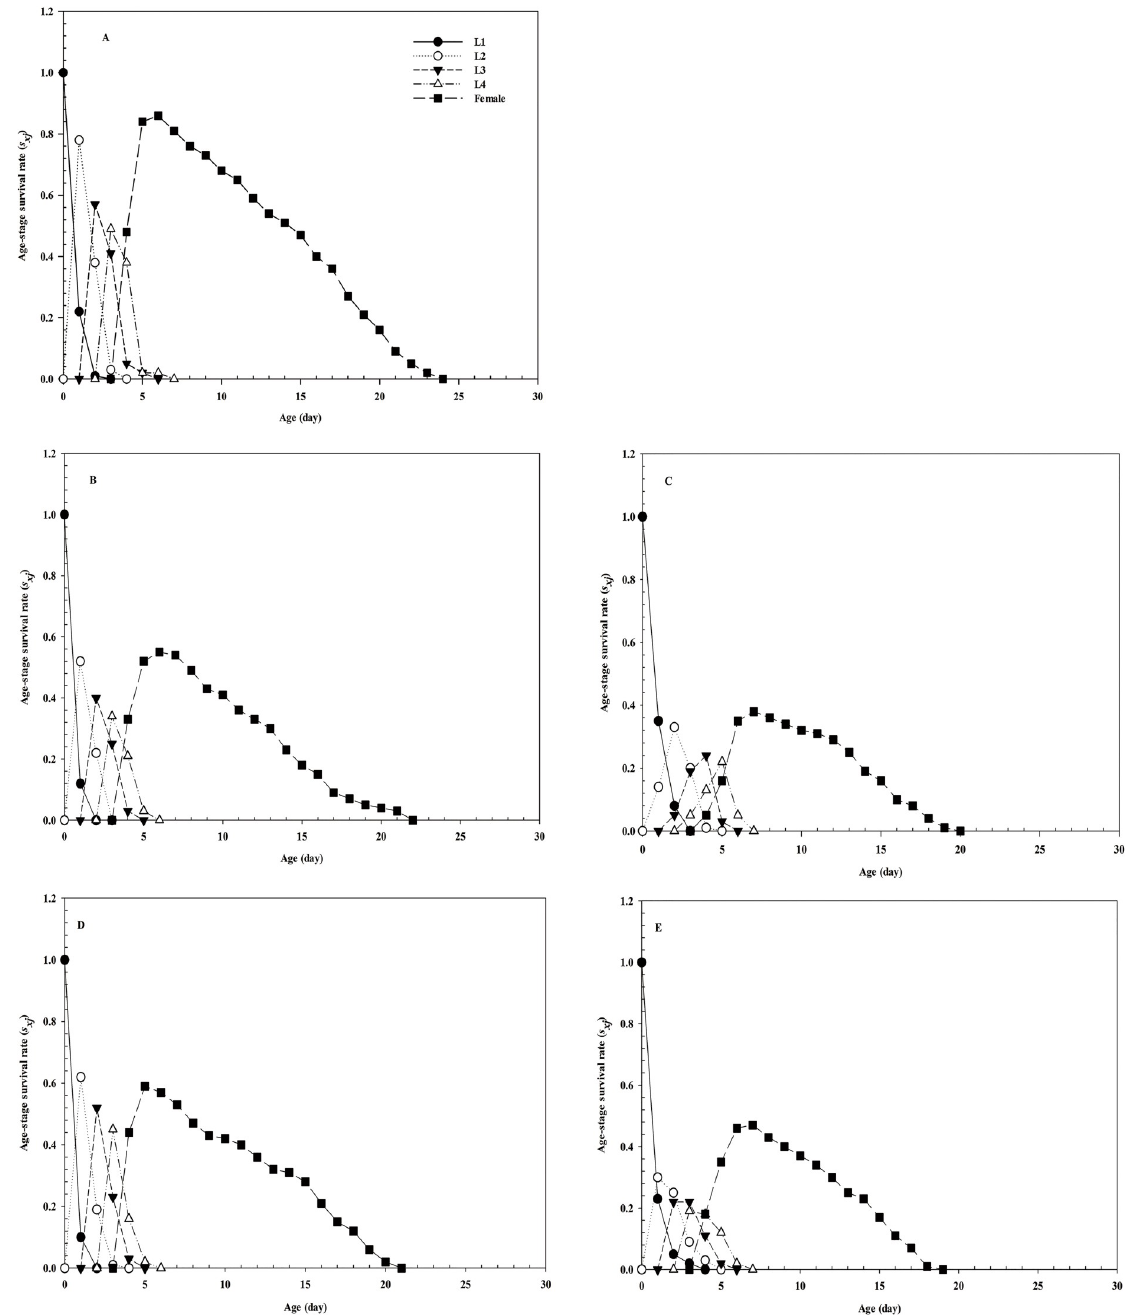
Fig 1. Age-stage specific survival rate ( s xj ) of A . glycines . The s xj of A . glycines in the control (A), LC 30 imidacloprid (B), LC 50 imidacloprid (C), LC 30 thiamethoxam (D), and LC 50 thiamethoxam (E) groups. L1 = s L3 = s xj of the third instar nymphs; and L4 = s xj of the fourth instar